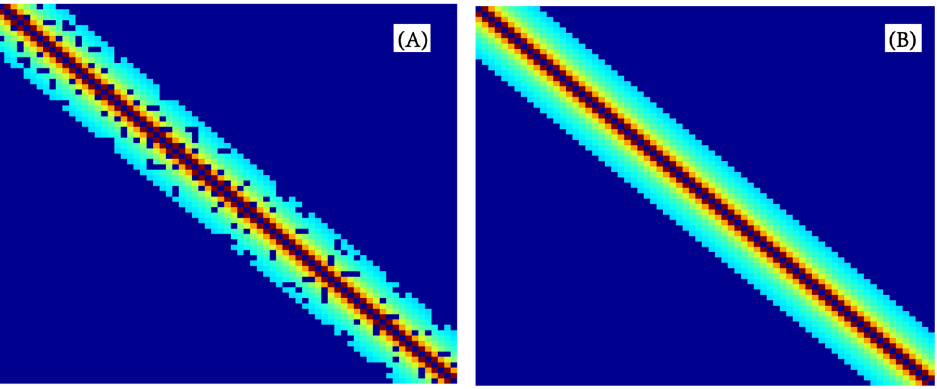
Figure 2. SB interferograms. ( A ) Conventional SB interferograms; ( B ) adequate SB interferograms.